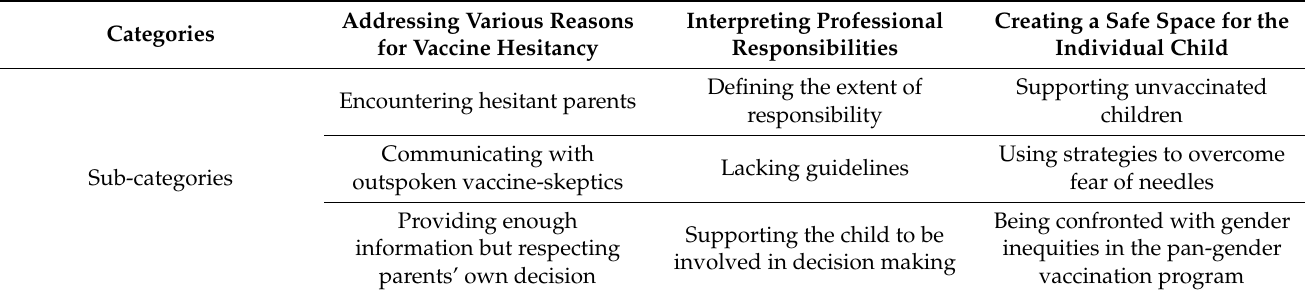
Table 3. Results of data